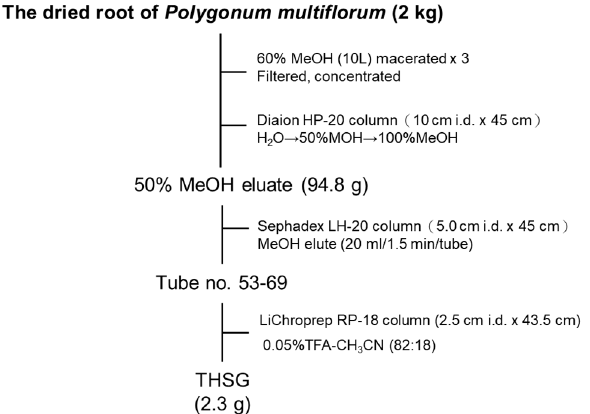
Figure 2. The isolation flowchart of 2,3,5,4 ′ -Tetrahydroxy-stilbene-2- O - β - D -glucoside (THSG) from Polygonum multiflorum Thunb. (PM).